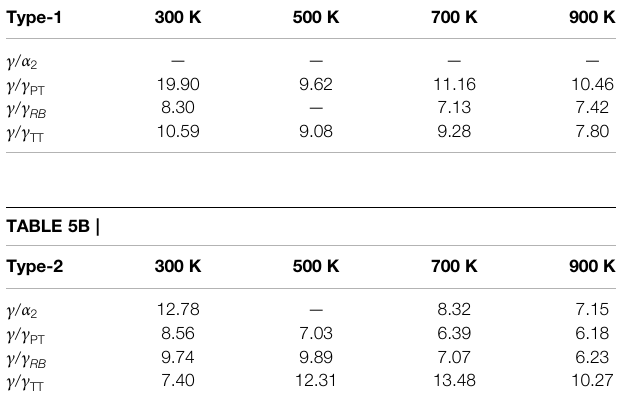
ρ observed inMD simulations(black)andthenormalizeddamage-